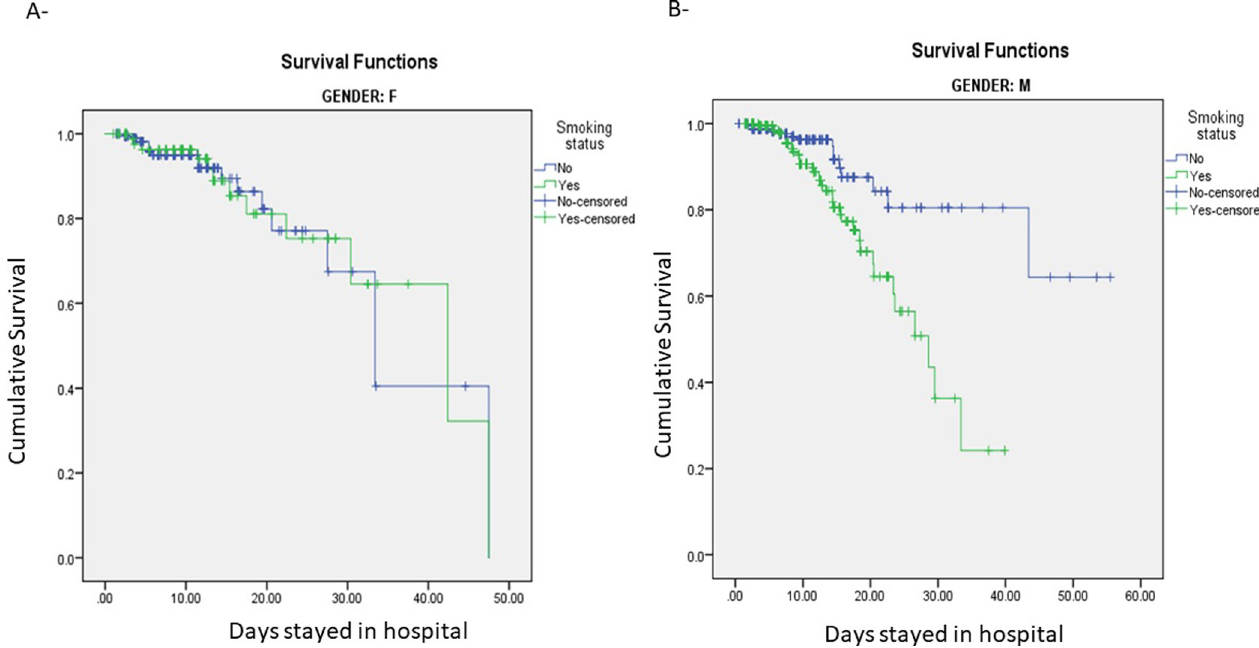
Fig 2. Kaplan-Meier survival curve for smokers (green line) and non-smokers (blue line) as stratified by Sex. A) F = Female (p = 0.893). B) M = Male (p = 0.001).